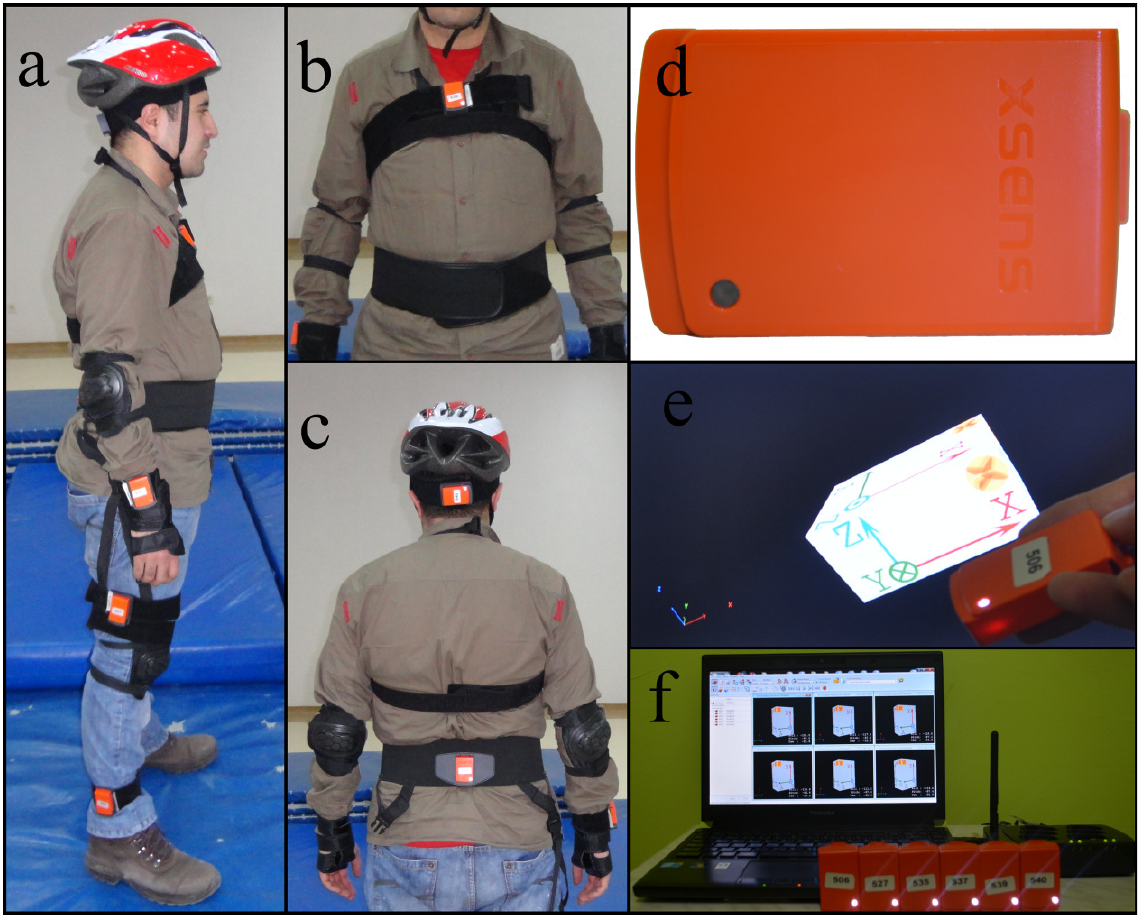
Figure 1. ( a – c ) The configuration of the six MTw units on a volunteer’s body; ( d ) single MTw unit, encasing three tri-axial devices (accelerometer, gyroscope, and magnetometer) and an atmospheric pressure sensor; ( e ) the three perpendicular axes of a single MTw unit; ( f ) remote computer, Awinda Station and the six MTw